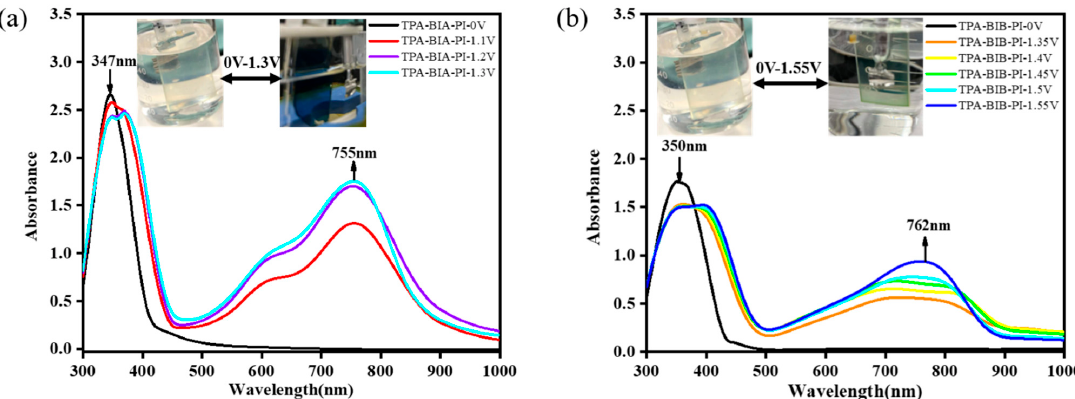
Figure 9. On the ITO–coated glass substrate (in CH 3 CN, 0.1M TBAP is used as the supporting ele–trolyte) the spectral changes in TPA-BIA-PI ( a ) and TPA-BIB-PI ( b ) with increasing voltage.